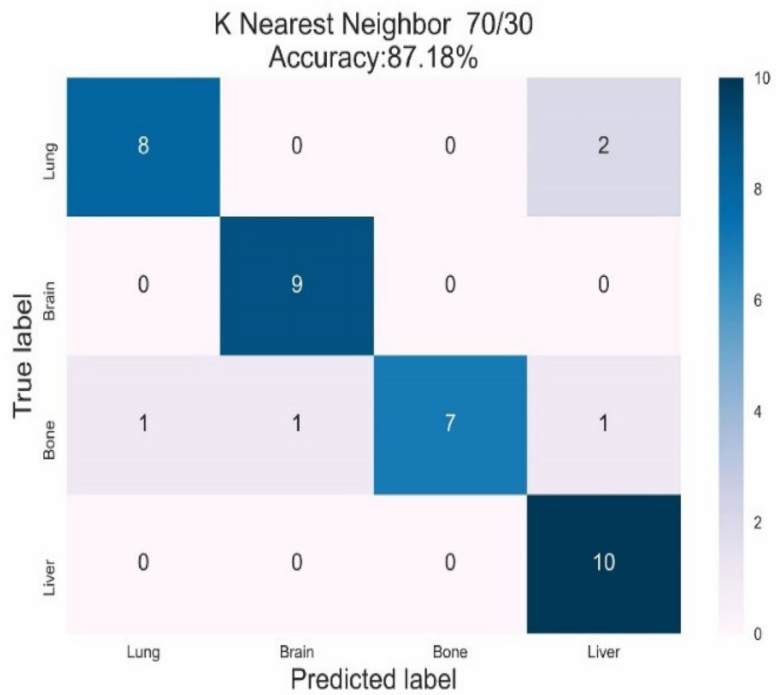
Figure 21. Confusion Matrix (K-Nearest Neighbor Classifier).